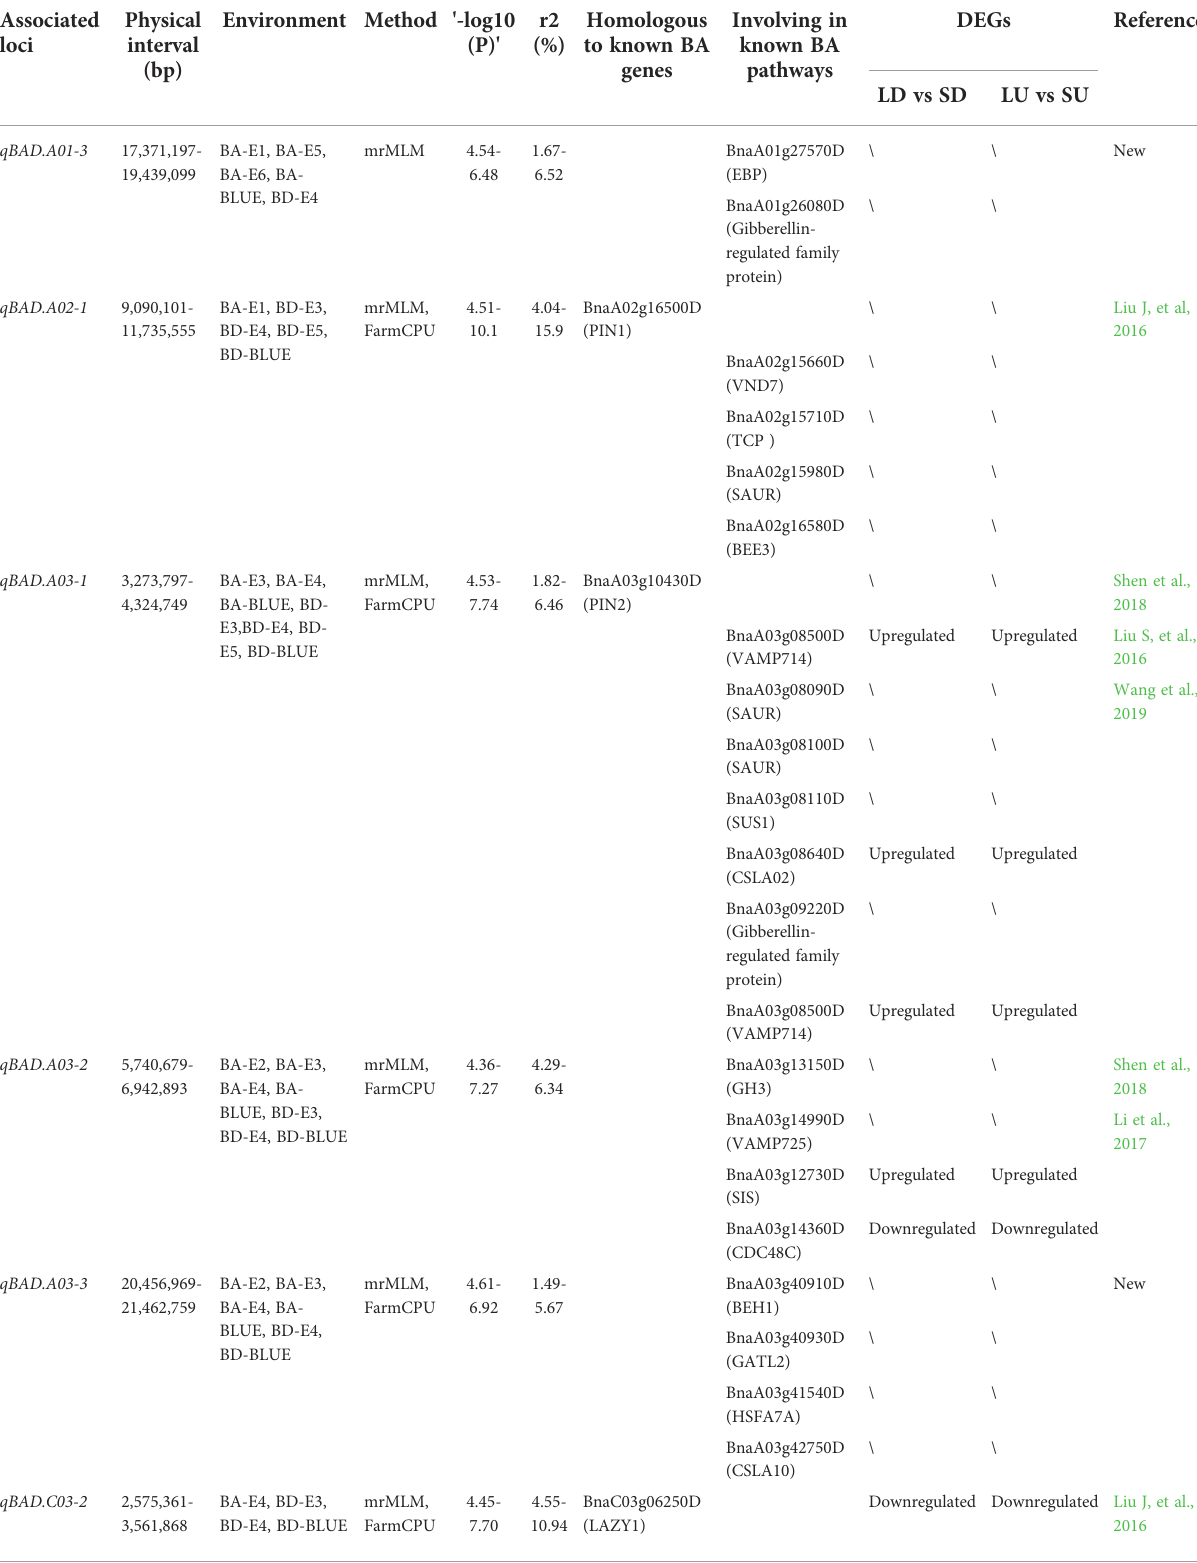
TABLE 1 10 stable association loci of branch architecture in oilseed